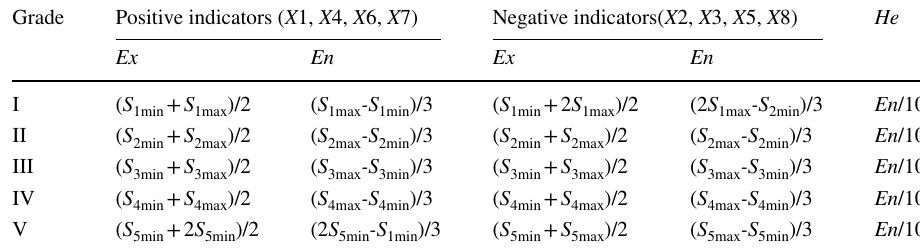
Table 1 Calculation methods of cloud model index